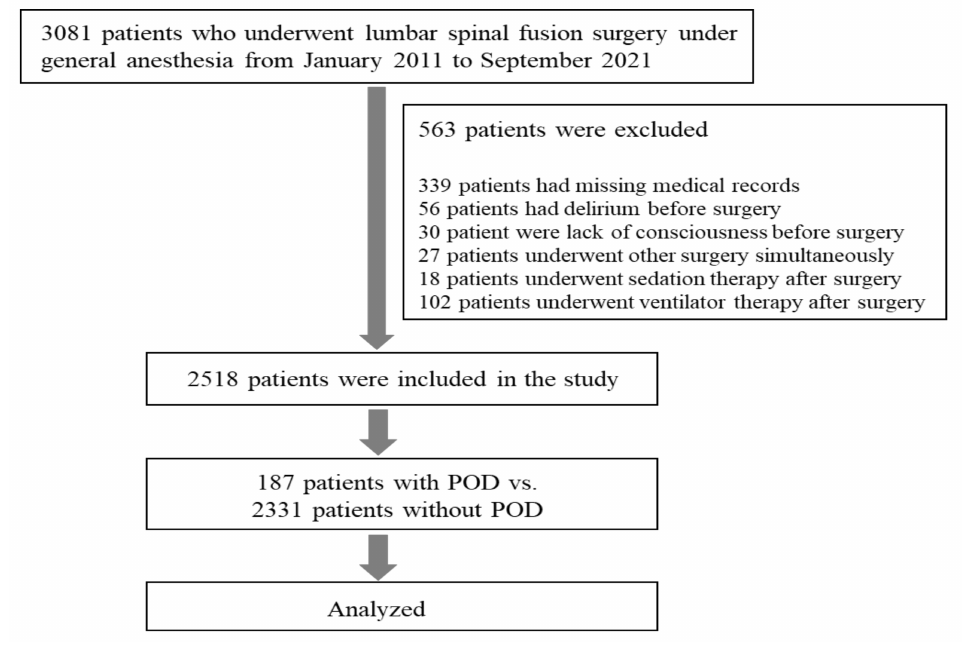
Figure 1. Flow chart of the enrollment process. POD, postoperative